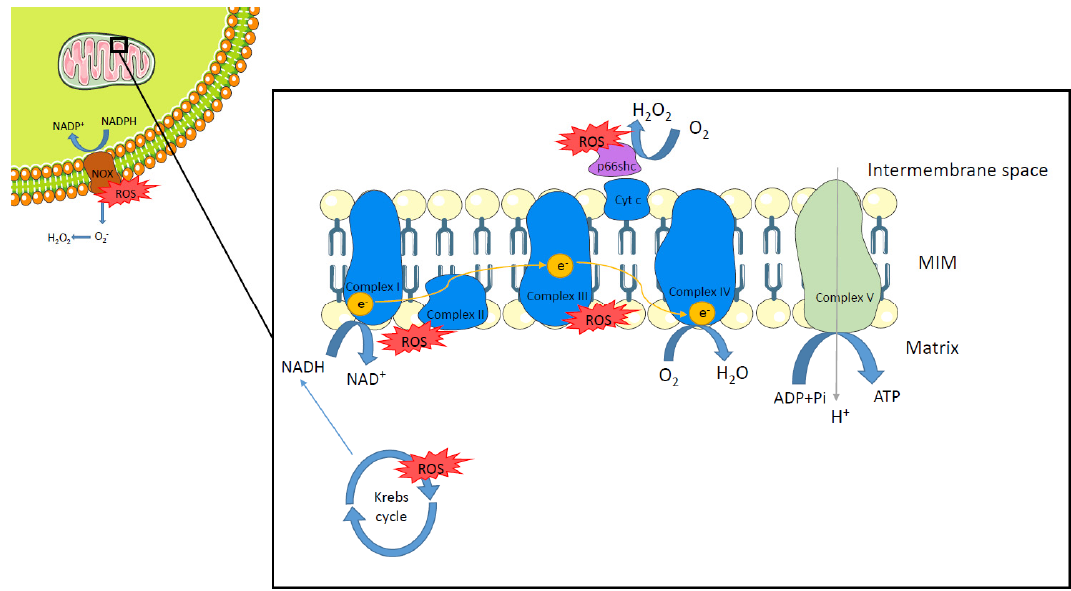
Figure 1. Sources of reactive oxygen species. Reactive oxygen species (ROS) are generated at different sites within the cell. Respiratory chain complexes I and III (in blue) produce ROS as a byproduct of electron transfer in mitochondria. Several enzymes involved in the Krebs cycle are also reported as sources of ROS. p66shc (in purple), by oxidizing cytochrome c (Cyt C), is able to generate ROS within the mitochondria intermembrane space. The NADPH oxidase (NOX) family of enzymes (in brown) are another important source of ROS by reducing oxygen to generate superoxide. MIM: mitochondria inner membrane.